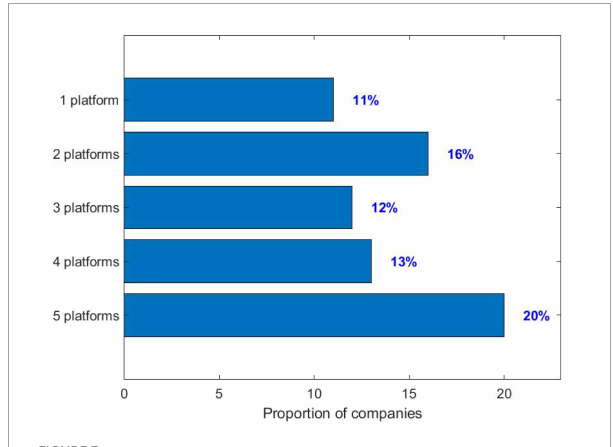
FIGURE3 Number of social media platforms used by companies in the energy and resource sector.